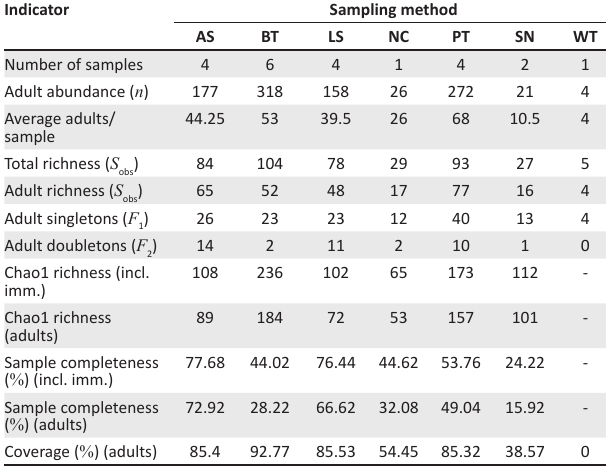
TABLE 2: Assessment of the efficacy of seven sampling methods used during the SANSA II field survey in the Ophathe Game Reserve in KwaZulu-Natal, October